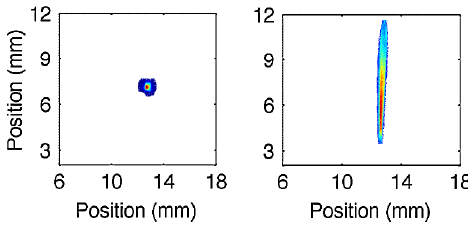
FIG. 2. Deflected 280 pC, 3 ps beam image (right picture) compared to nondeflected one (left picture).